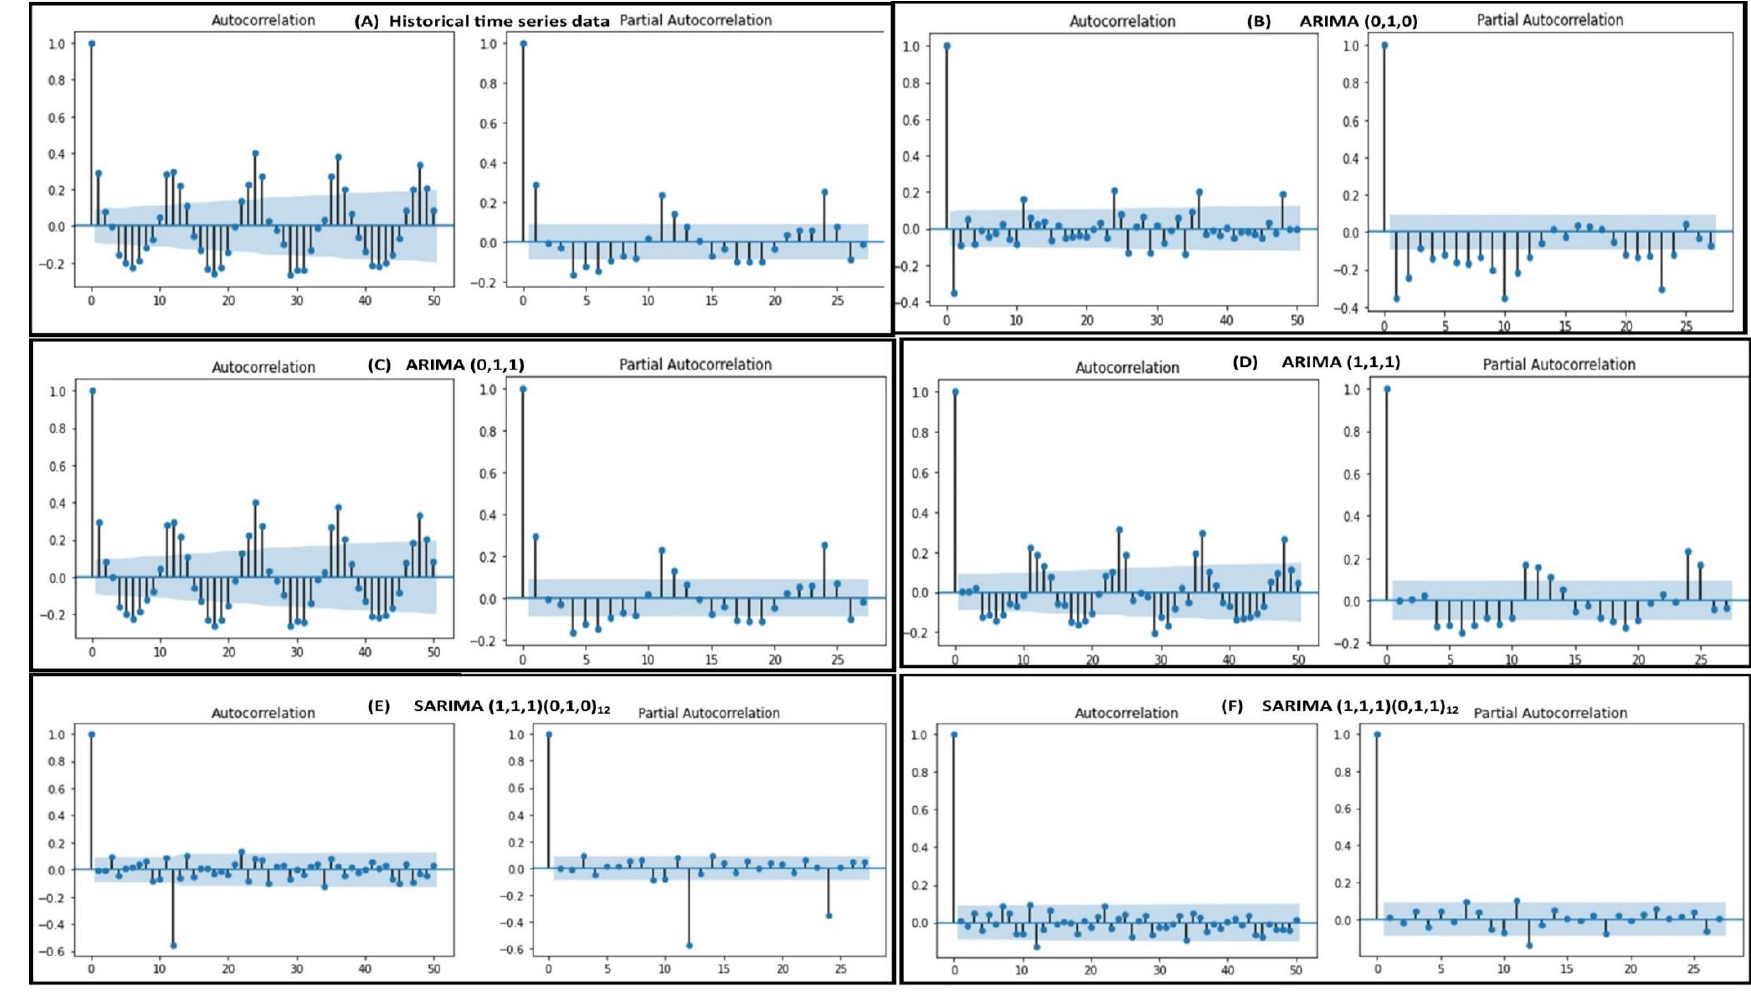
Figure 3. ACF and PACF plots for different ARIMA and SARIMA models.